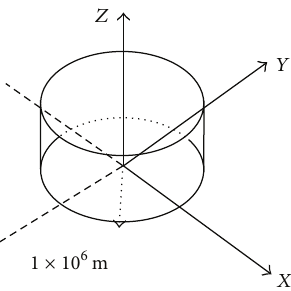
Figure 18: An example of many cylindrical loci for evaluating the TOA